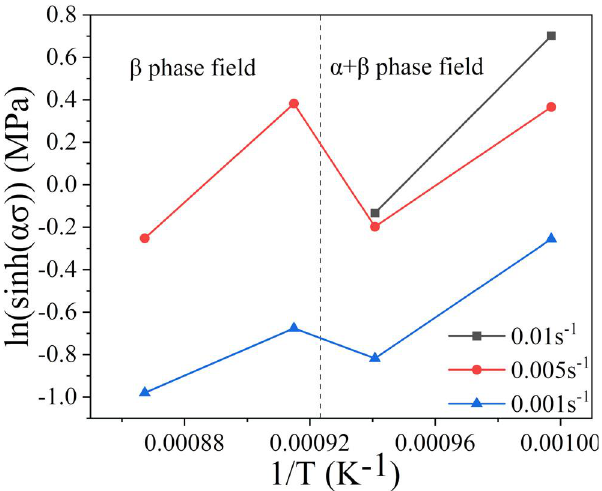
Figure 7. The relationship between ln(sinh( ασ )) and the deformation temperature ( T −1 ).